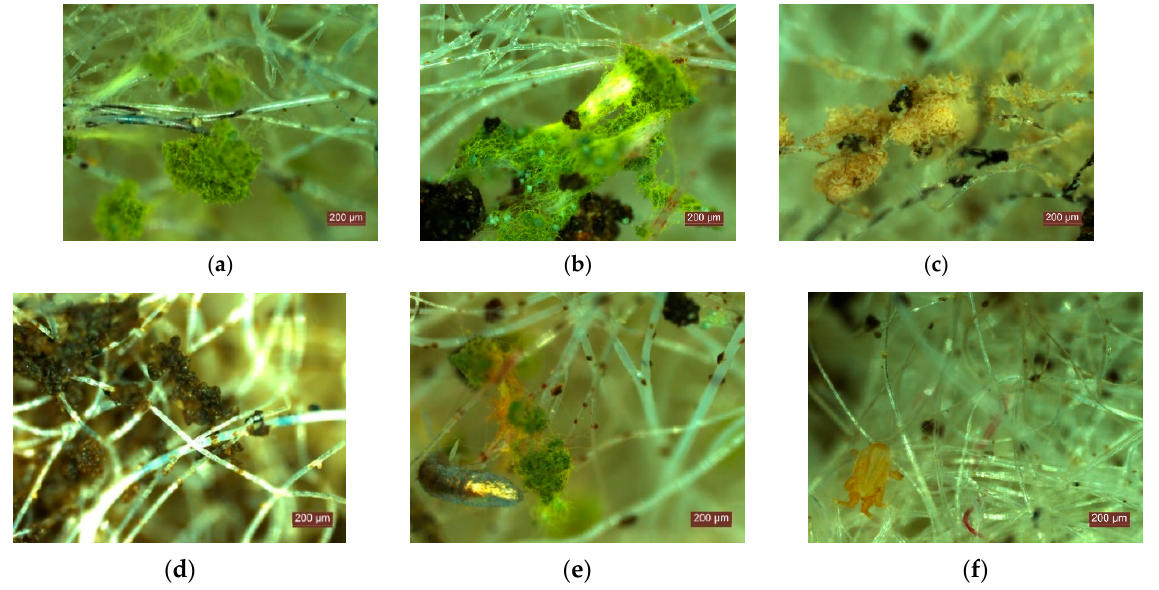
Figure 7. Instances regarding microscopic analysis of test specimens by holding in soil for six months ( a – f ).